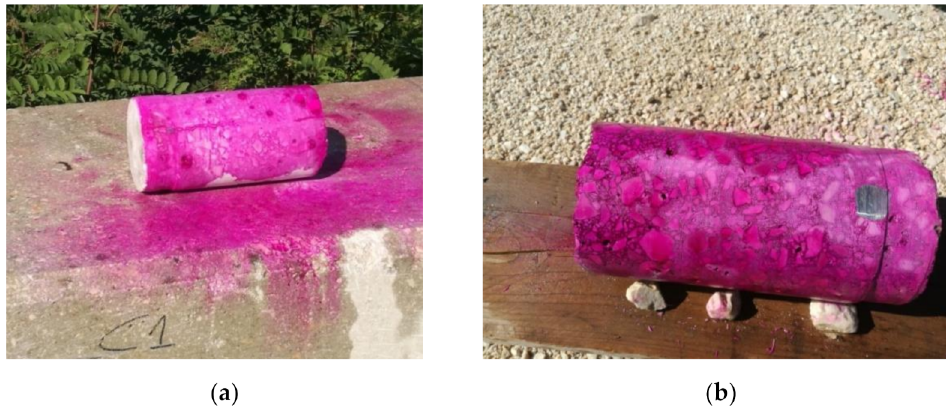
Figure 6. Samples C1 ( a ) and C2 ( b ) after phenolphthalein spraying.